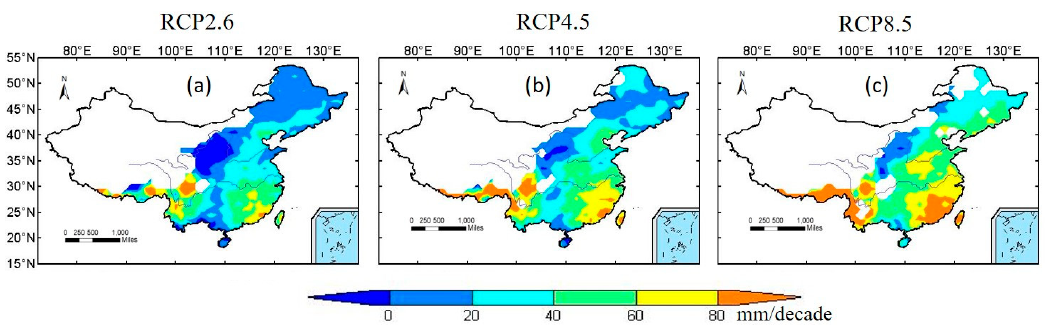
Figure 7. Spatial pattern of ∆ FA from 2011 to 2099 projected by multi-model ensembles (MME) (confidence regions only, unit: mm/decade).